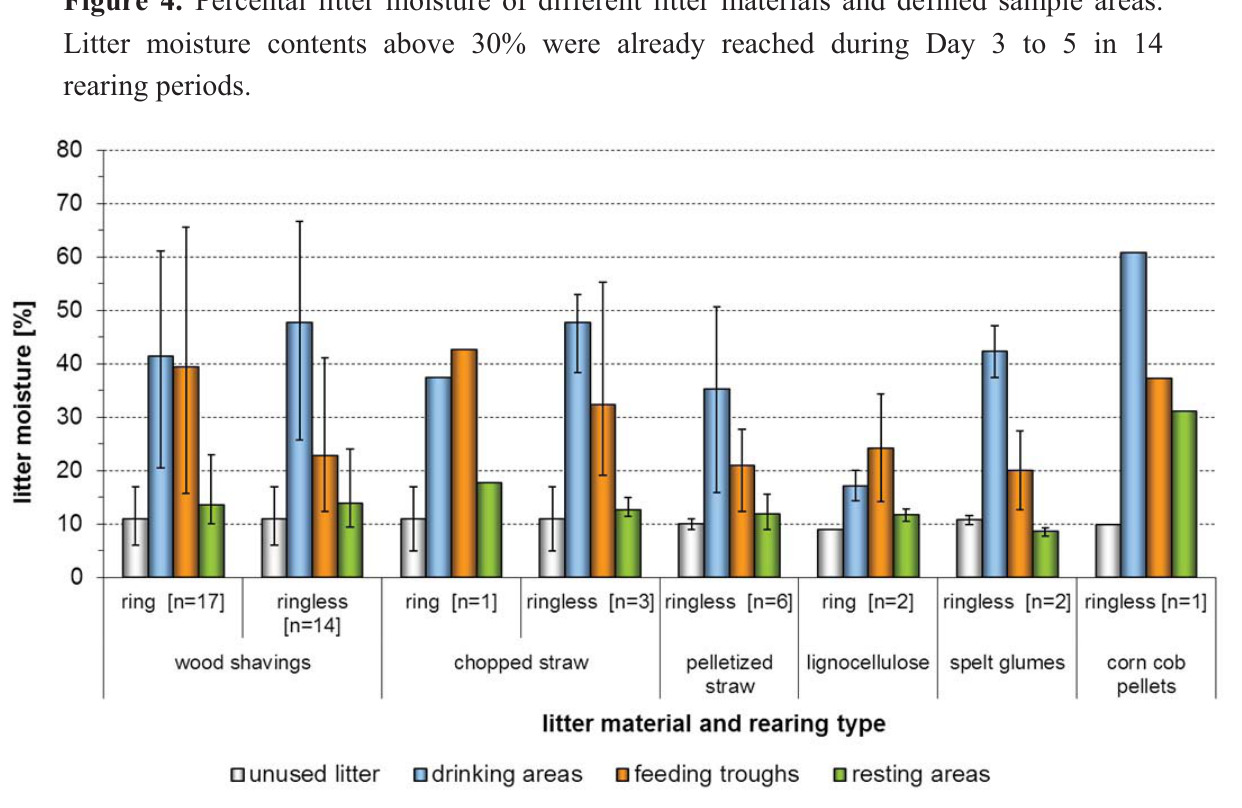
Figure 4. Percental litter moisture of different litter materials and defined sample